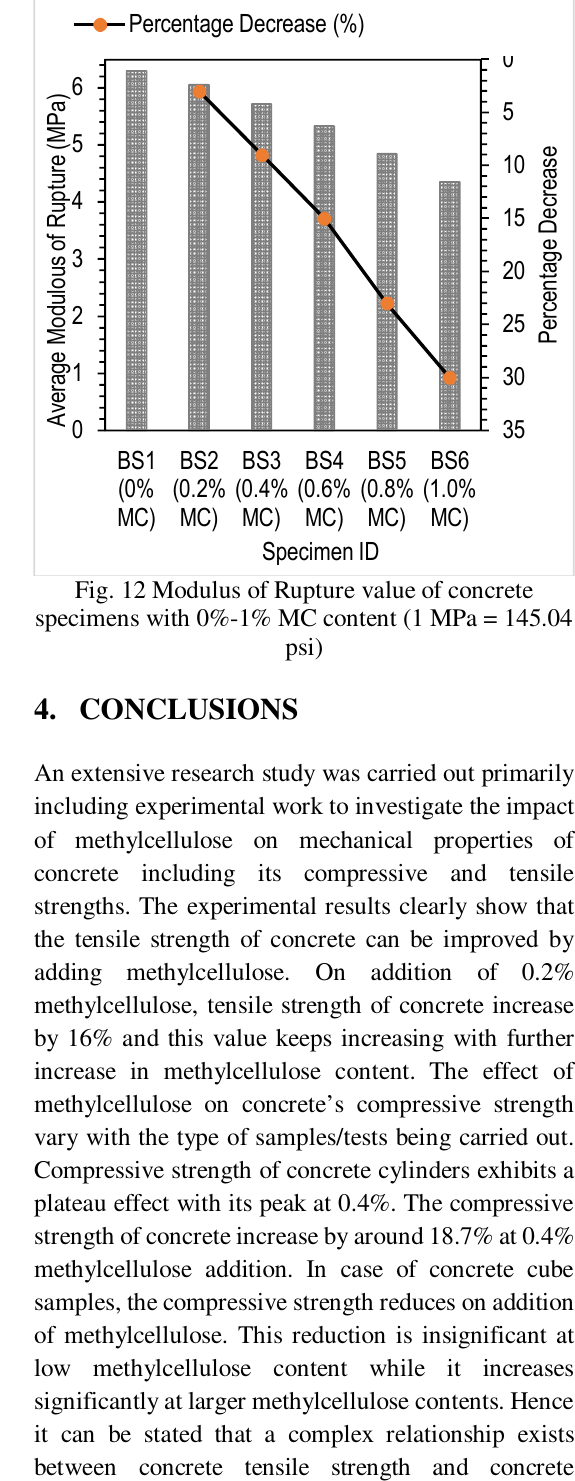
Table 6: Modulus of Rupture test results Sr.